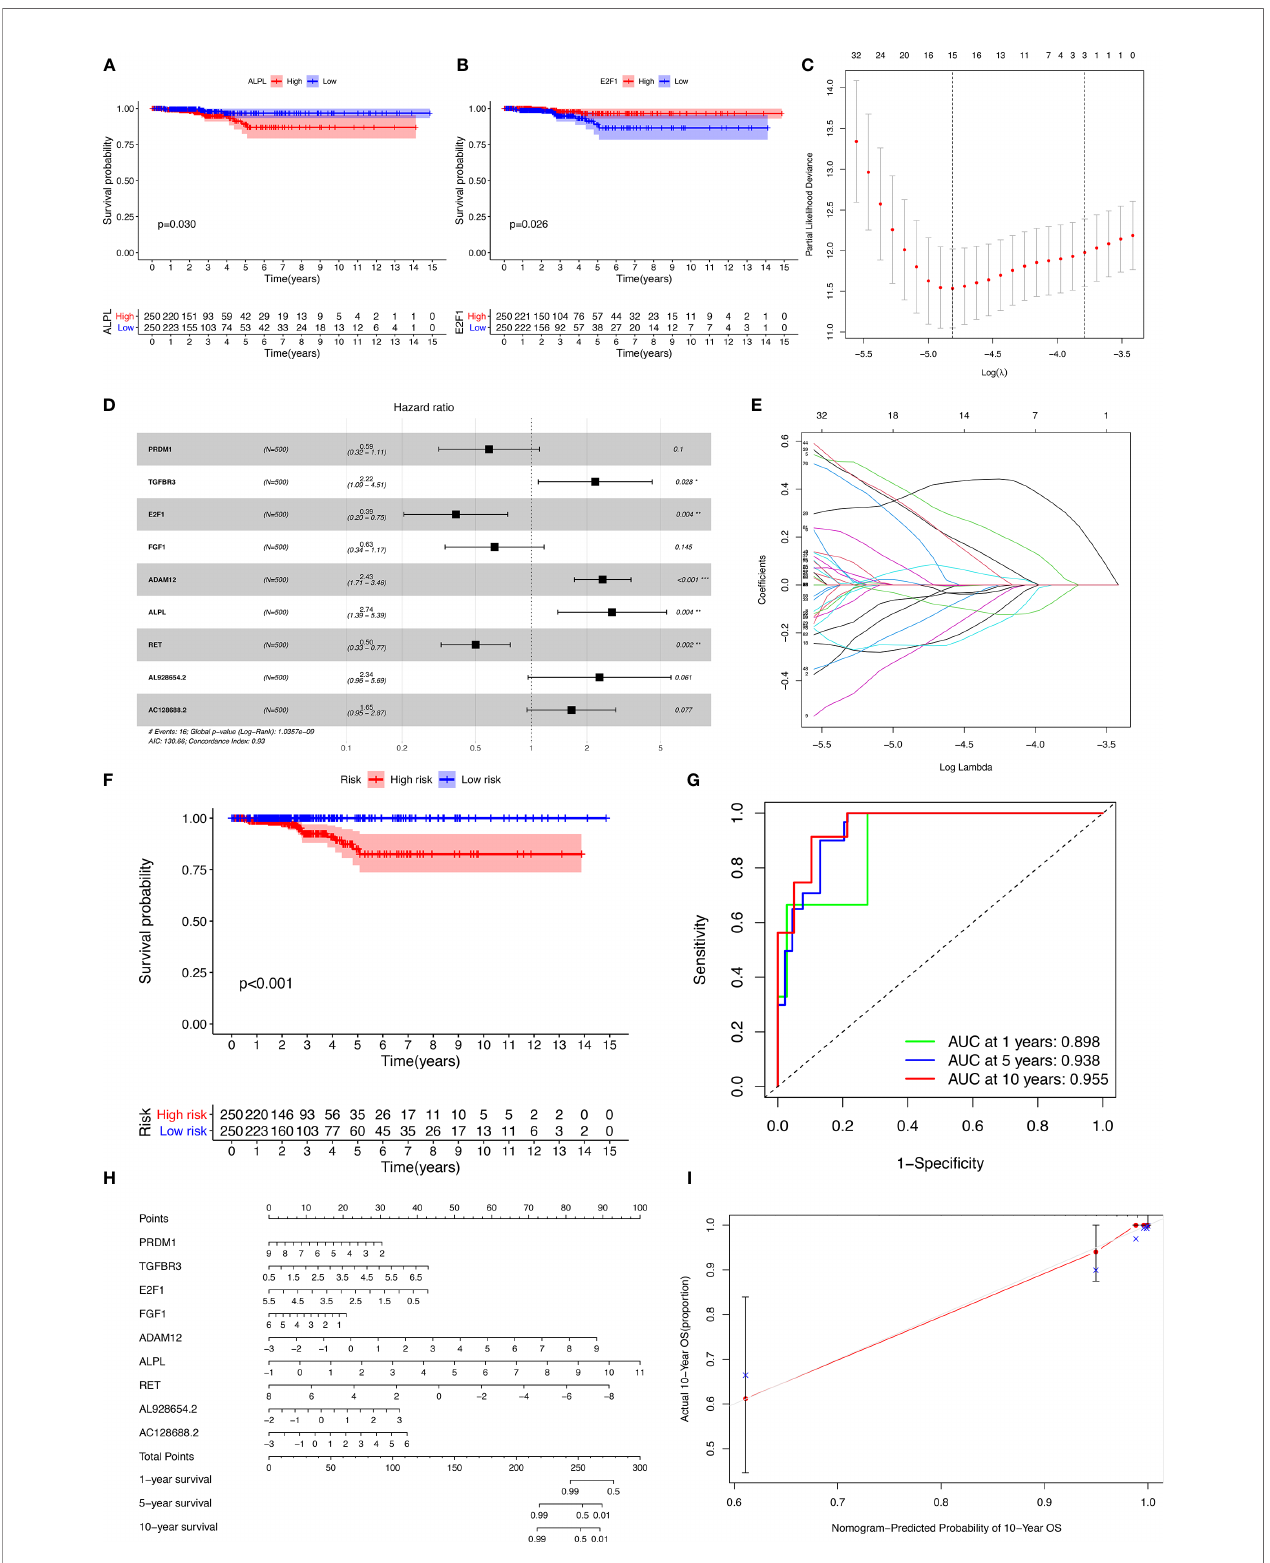
FIGURE 3 | Kaplan-Meier analysis of different genes (A, B) ; the results of the Lasso regression (C – E) ; ROC (receiver operating characteristic curves) and the calibration curves (F, G) ; nomogram based on the model (H) ; calibration curves of the nomogram (I)